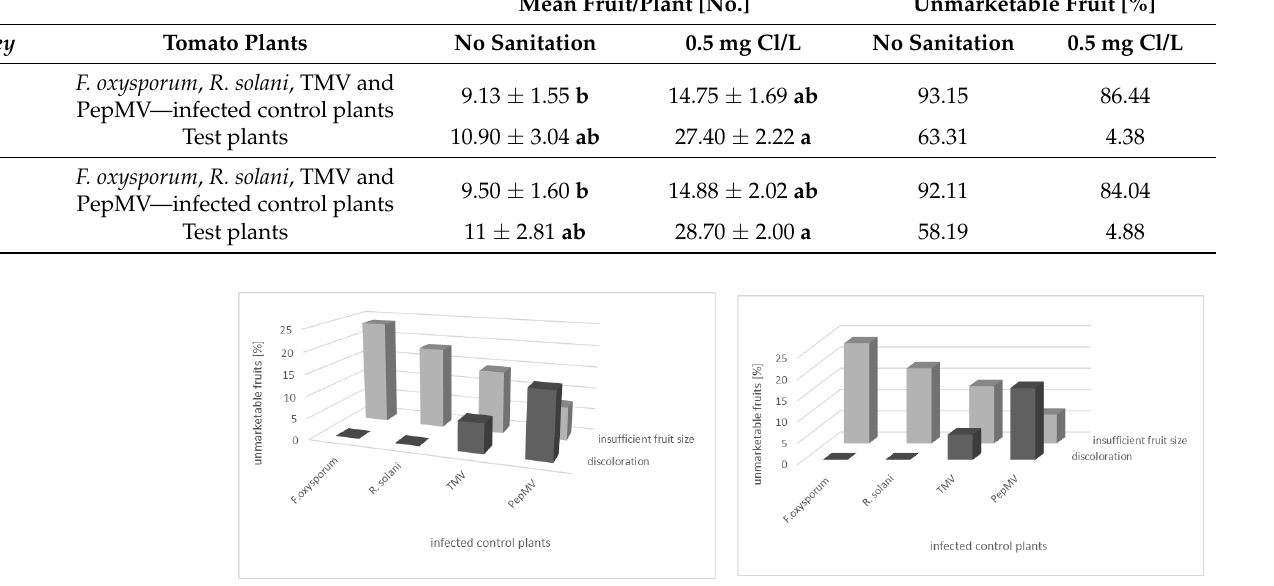
Figure 5. Influence of a single-pathogen infection (control plants B1 to B8) on color and size of tomato fruit harvested over a 10-week period. Tomato plants were grown in a hydroponic NFT system with recirculating fertigation solution that was disinfected weekly to prevent pathogen spread. Fruits with discoloration, diameter less than 40 mm or cracks were considered unmarketable. ( Left ): first survey, ( right ): second survey.